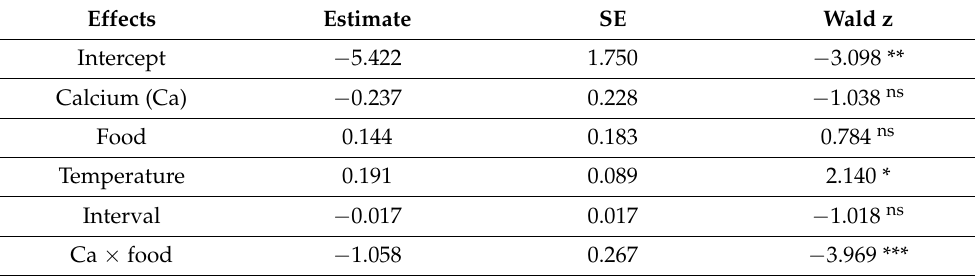
Table 1. Results of the discrete-time survival model with mixed effects to test the effects of calcium concentration, food concentration, and temperature on the hazard of mortality of Daphnia .